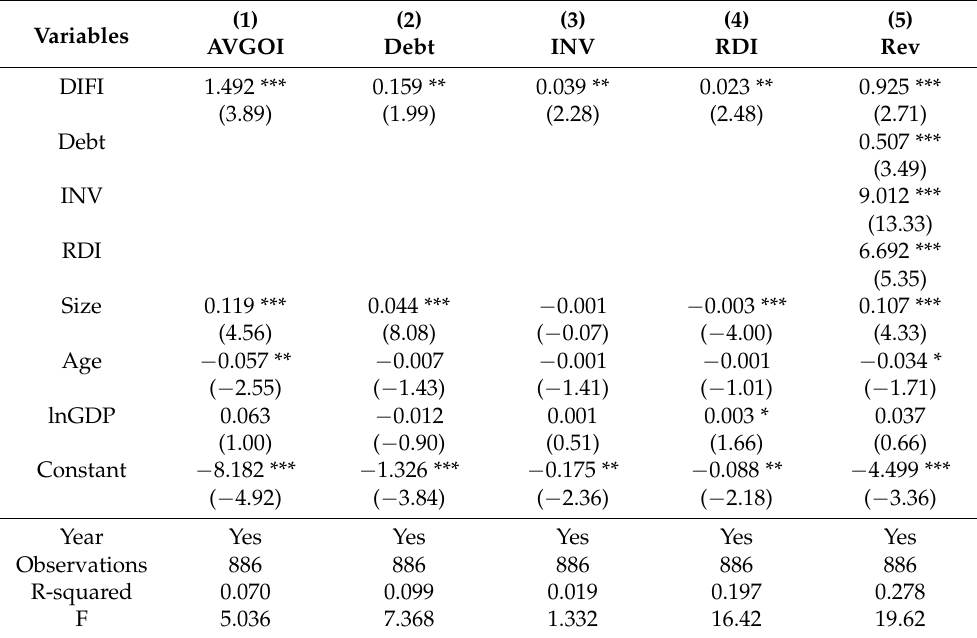
Table A3. Robustness test of mediating effect with independent variable lagged for one time